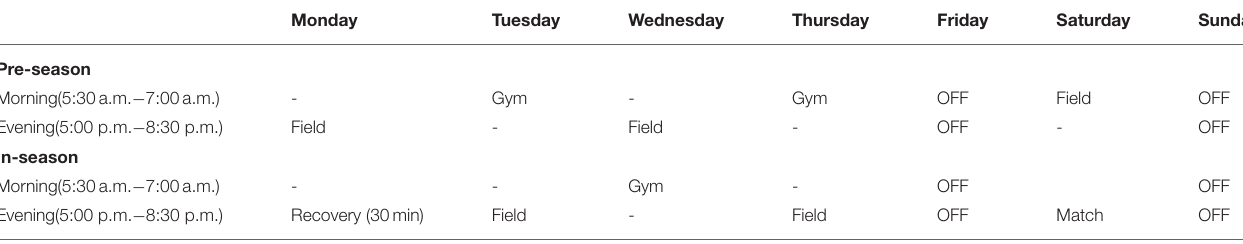
TABLE 1 | Summary of a typical training week during the pre-season and in-season